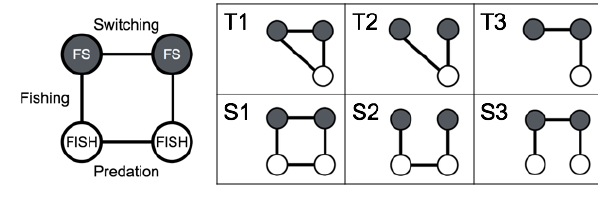
Fig. 2 . Left: a social-ecological motif in which grey social nodes represent fishing strategies, and white ecological nodes represent target fish species. A link between social nodes represents fishers switching between fishing strategies, and a link between ecological nodes represents predator-prey relationships. A link from social node to ecological node represents fishing. Motif links are unweighted and undirected. The set of six motifs on the right side shows the social- ecological motifs that are included in this study.